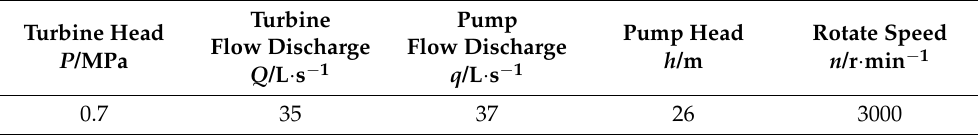
Table 1. Working condition of the fire turbopump.